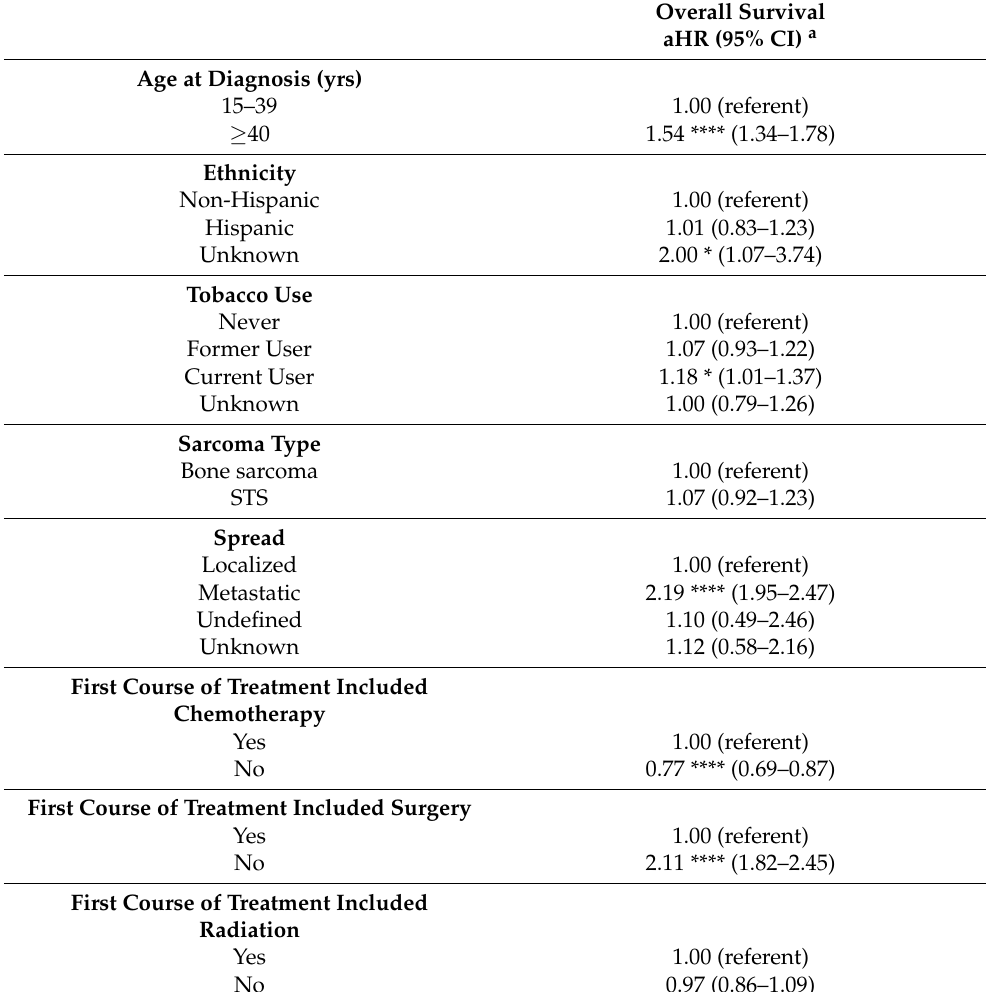
Table 2. Selected demographic and clinical characteristics analyzed in a multivariable model on overall survival in individuals diagnosed with sarcoma at MCC,